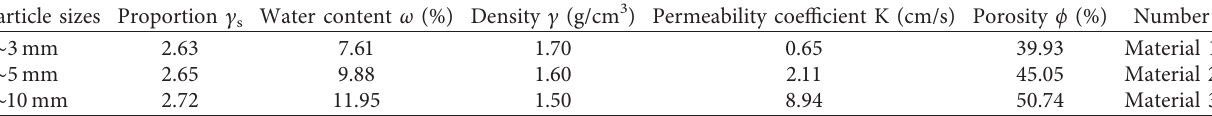
Table 1: Elementary properties of three grouted gravel (sand) stone body.